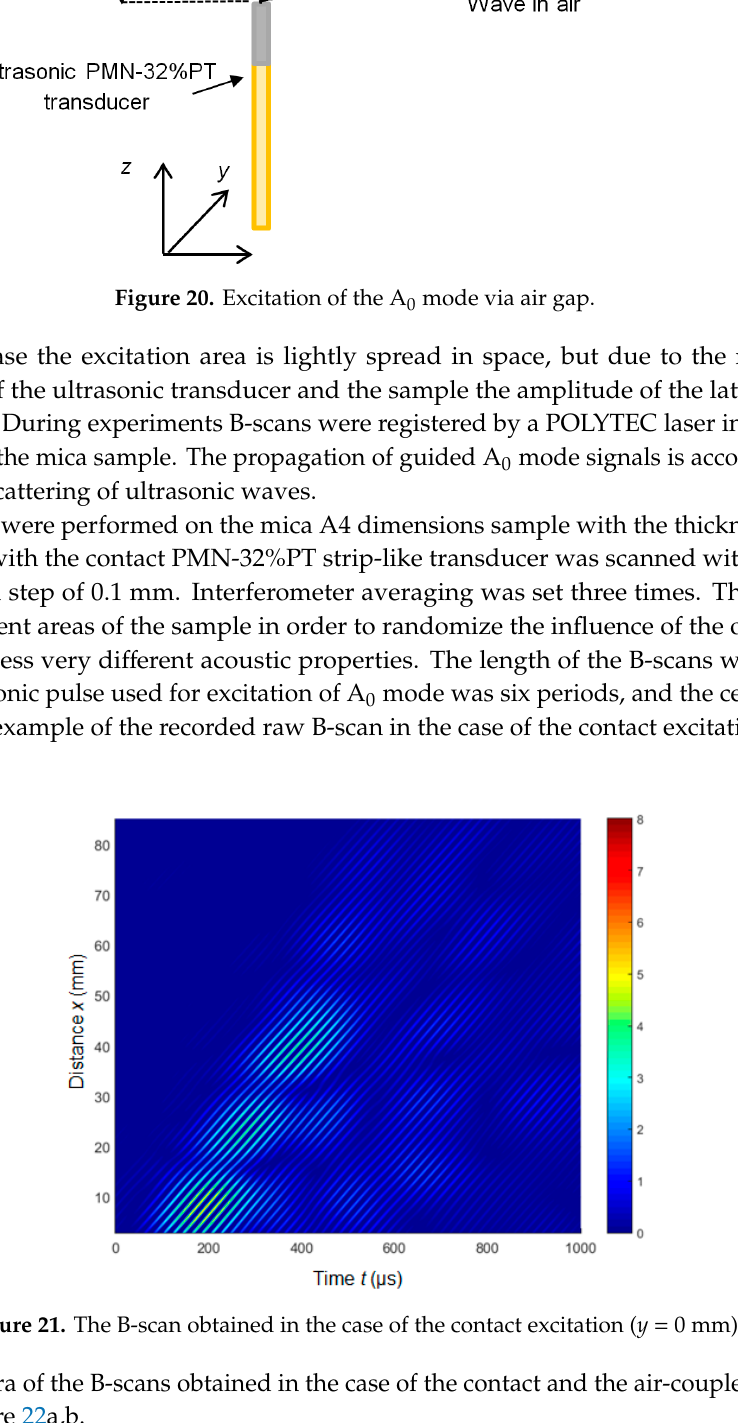
Figure 21. The B-scan obtained in the case of the contact excitation ( y = 0 mm).